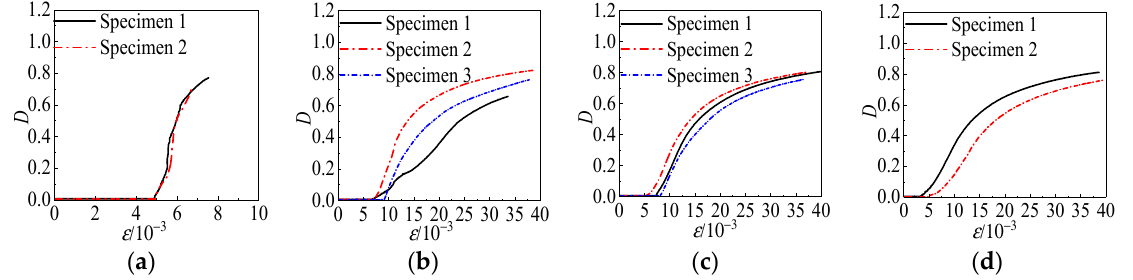
Figure 31. Damage factor of fiberless all-coral seawater concrete versus different variations. Parameters: ( a ) σ w = 0 MPa, ( b ) σ w = 6 MPa, ( c ) σ w = 12 MPa, and ( d ) σ w = 18 MPa